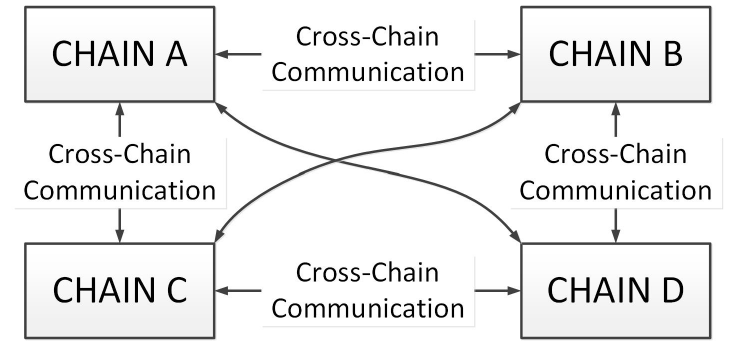
Figure 3. Cross-Chain network